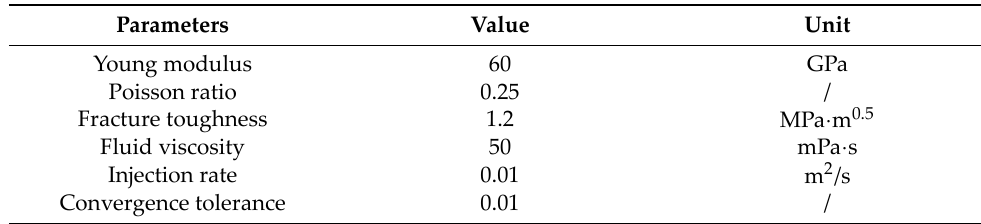
Table 1. Parameters for validation